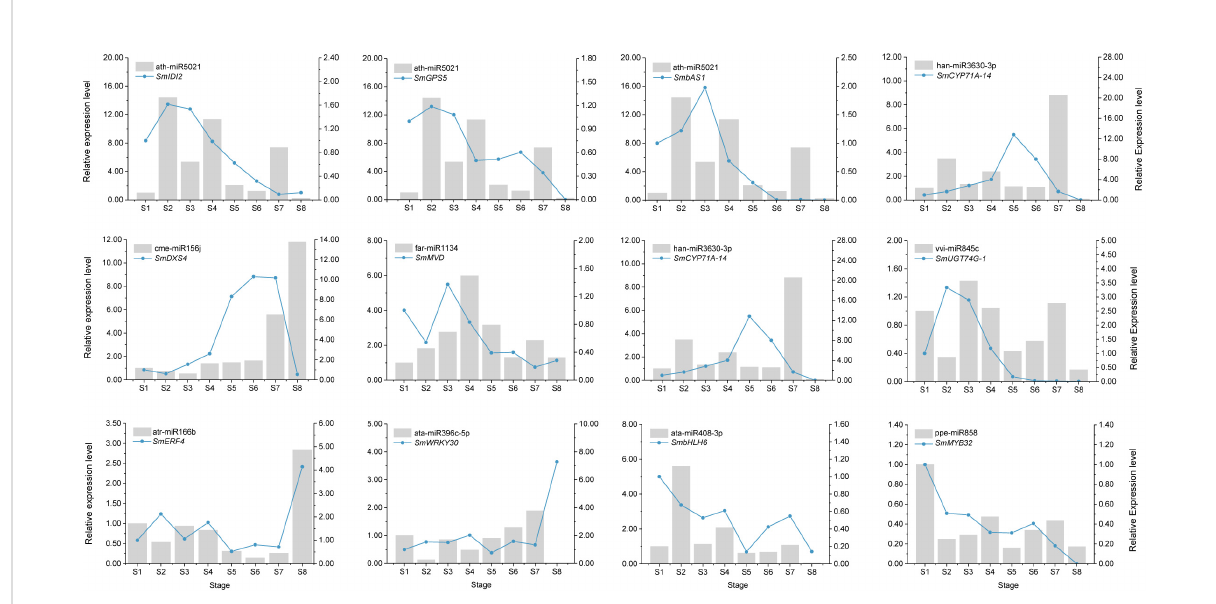
FIGURE 7 Expression correlation of miRNAs and their targets. The bars and lines indicate the relative expression level of miRNAs and their corresponding targets in the eight developmental stages of soapberry pericarps. The Y-axis on the left and right represents the abundance of the miRNAs and their targets, respectively. SnRNA U6 and SmACT were used for normalizing the relative expression of miRNAs and their targets, respectively. The expression level of the miRNAs and their corresponding targets in the stage S1 were set as 1.0. Relative expression level was calculated using the 2 – DD C t method. Data indicate the mean values of three biological